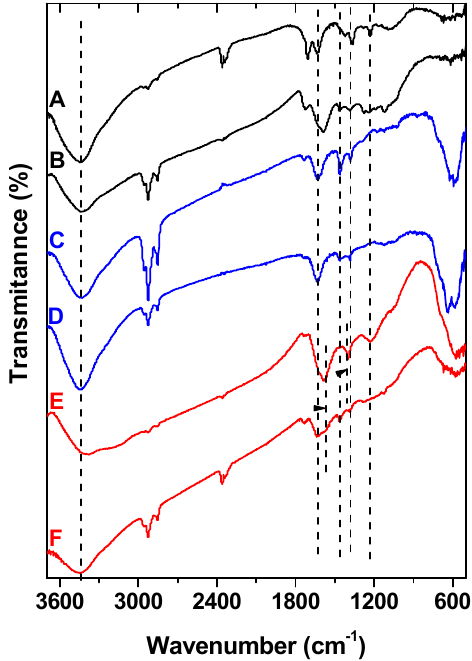
Figure 7. FT–IR spectra of: ( A ) GO; ( B ) GO dye–loaded; ( C ) mGOi; ( D ) mGOi dye-loaded; ( E ) mGOp; ( F ) mGOp